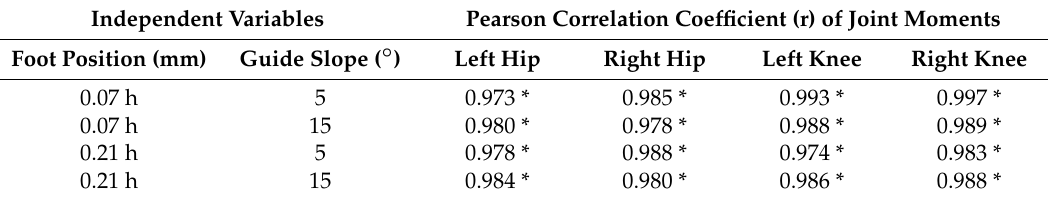
Table 9. Pearson correlation coefficients of measured and simulated joint moments (*: p < 0.001). Independent Variables Pearson Correlation Coefficient (r) of Joint Moments